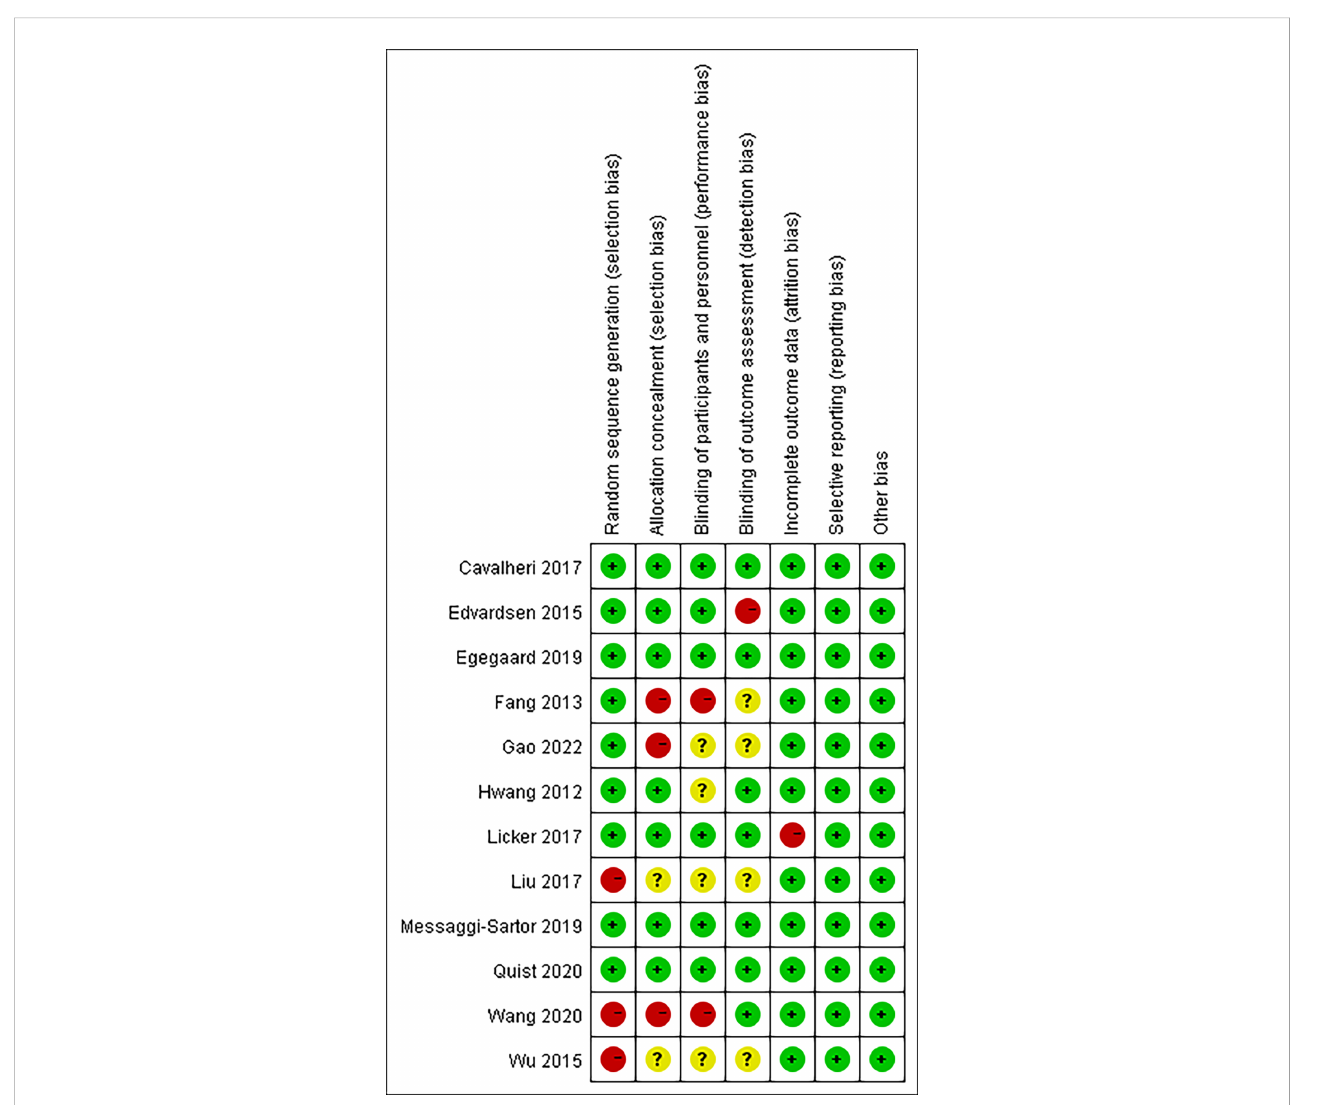
FIGURE 2 Risk of bias summary review authors ’ judgments about each risk of bias item for each included